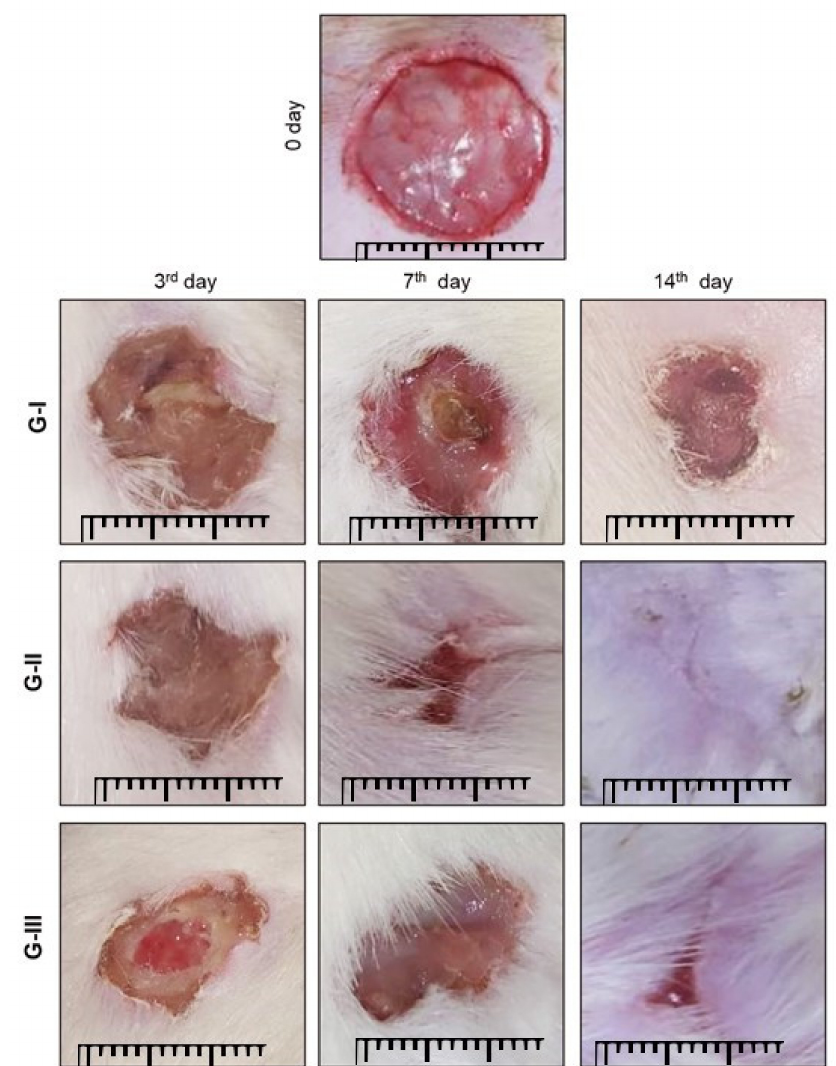
Figure 4. Photograph showing wound healing in GI, GII, and GIII at 3rd, 7th, and 14th days post- treatment, where the healing process accelerated in wounds treated with GI in comparison with GI and GIII